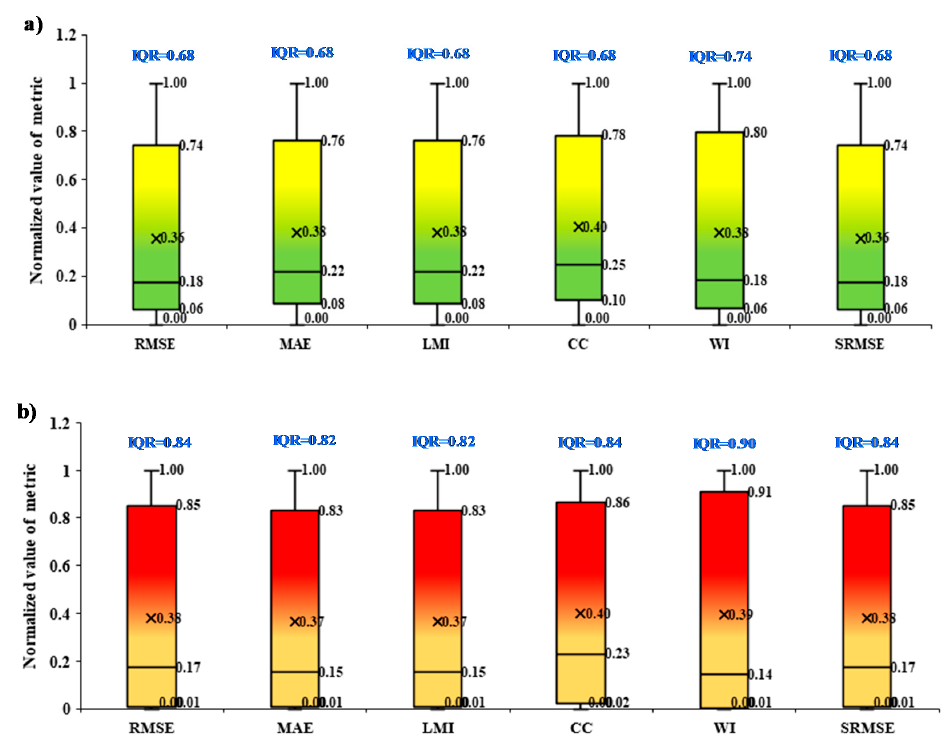
Figure 8. Boxplot of the model’s uncertainty based on performance index over ( a ) Training stage and ( b ) Testing stage.